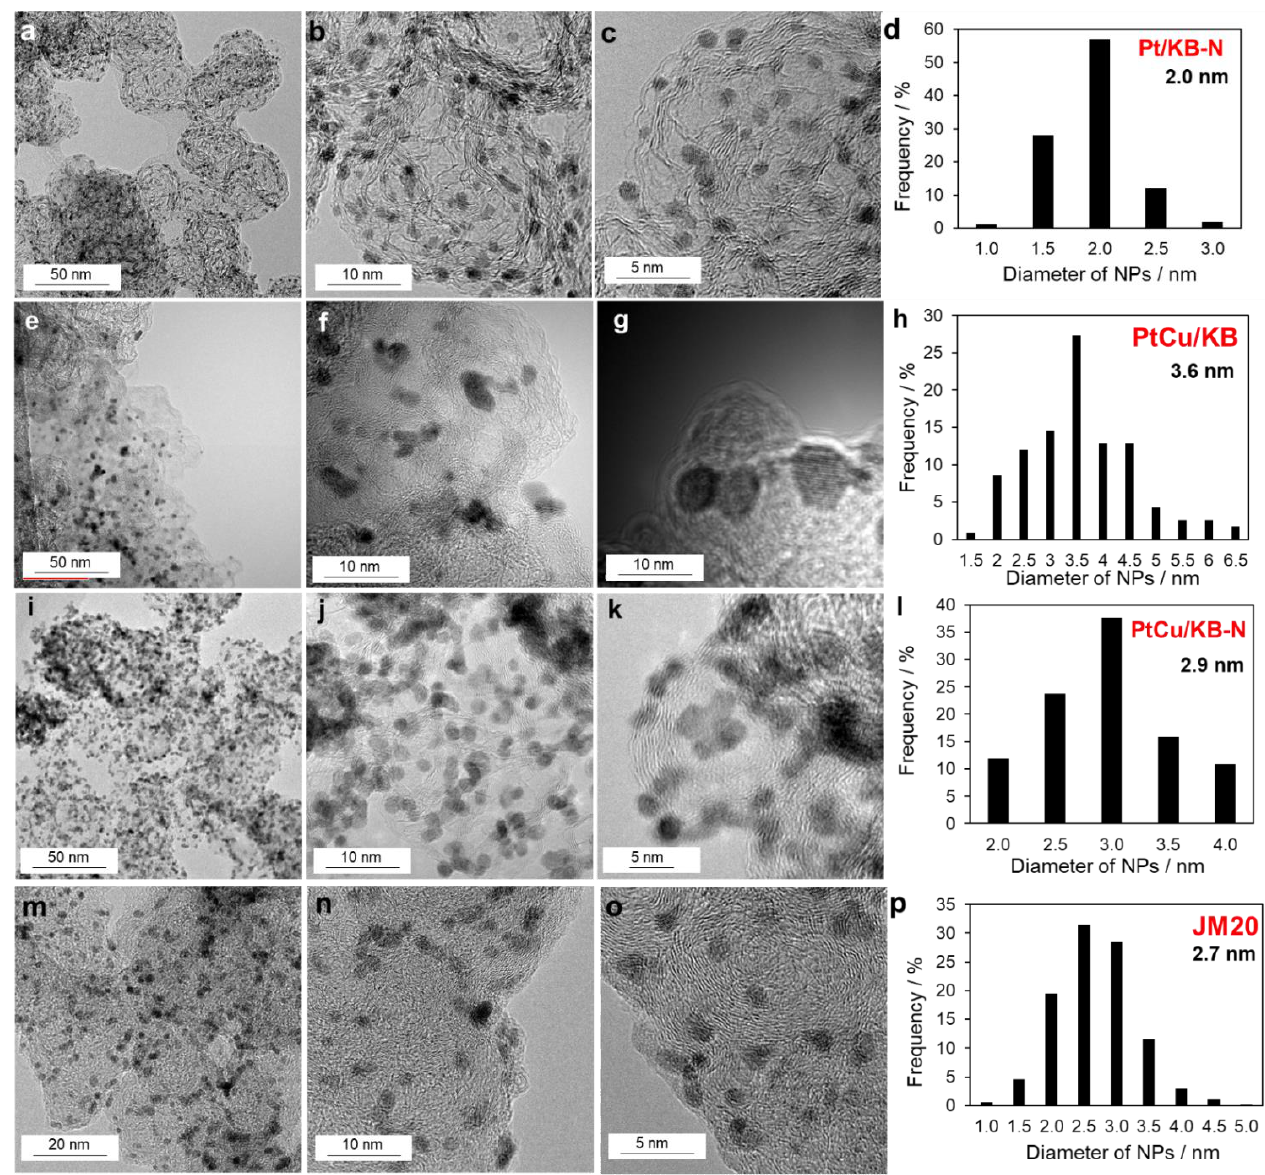
Figure 2. TEM of the samples: Pt/KB-N ( a – c ), PtCu/KB ( e – g ), PtCu/KB-N ( i – k ), JM20 ( m – o ), and NP size distribution histograms for the corresponding materials ( d , h , l , p